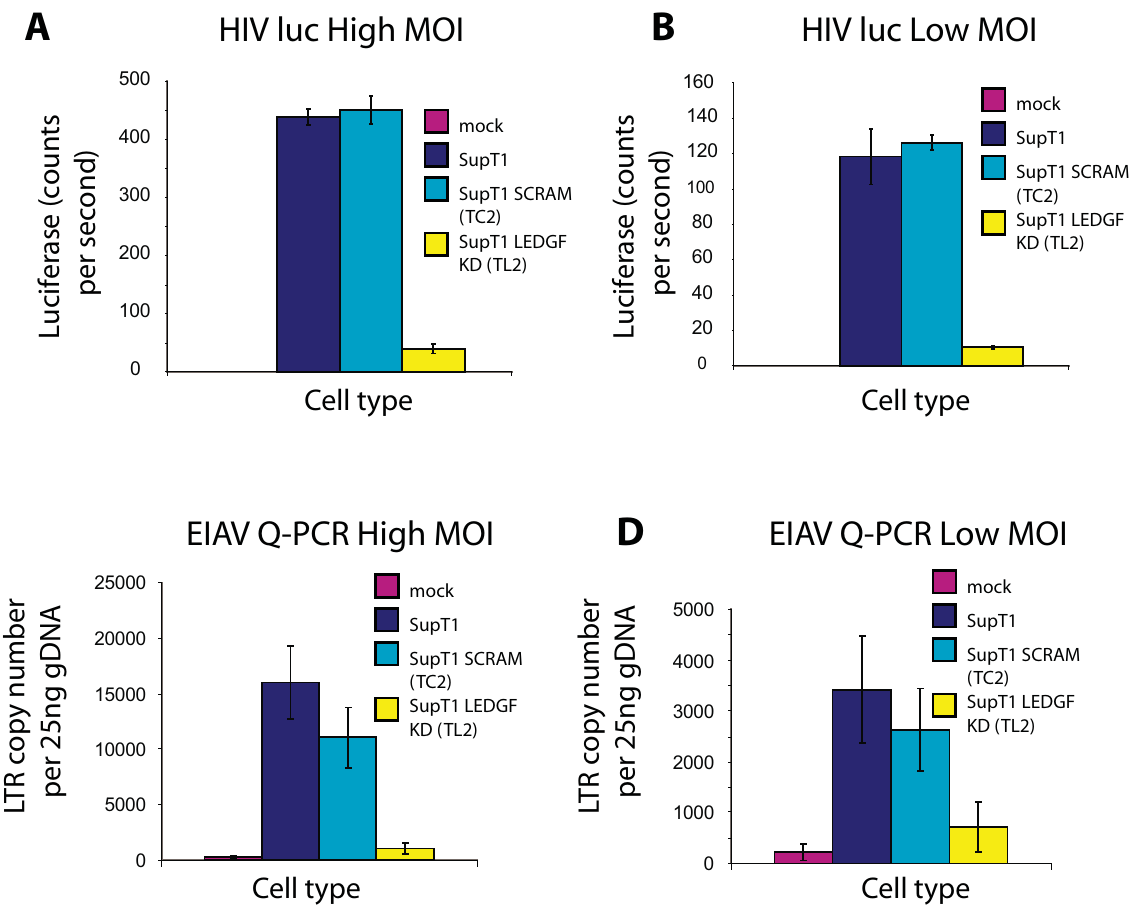
Figure 1. Effects of intensified knockdown of LEDGF/p75 in SupT1 cells on the efficiency of lentiviral infection. A) and B) HIV luc activity was compared for wild-type SupT1 cells, SupT1 containing a control scrambled shRNA (SCRAM), and LEDGF/p75 knockdown (KD) cells. A) High multiplicity of infection (80 ng p24); B) Lower multiplicity of infection (20 ng p24). The designation ‘‘p24’’ indicates the amount of viral stock, measured by the weight of the p24 capsid antigen applied to cells. C) and D) EIAV infectivity was compared in the SupT1 cell set as assayed by quantitative PCR for viral cDNA: C) high multiplicity (100 m l stock), D) lower multiplicity (25 m l stock).